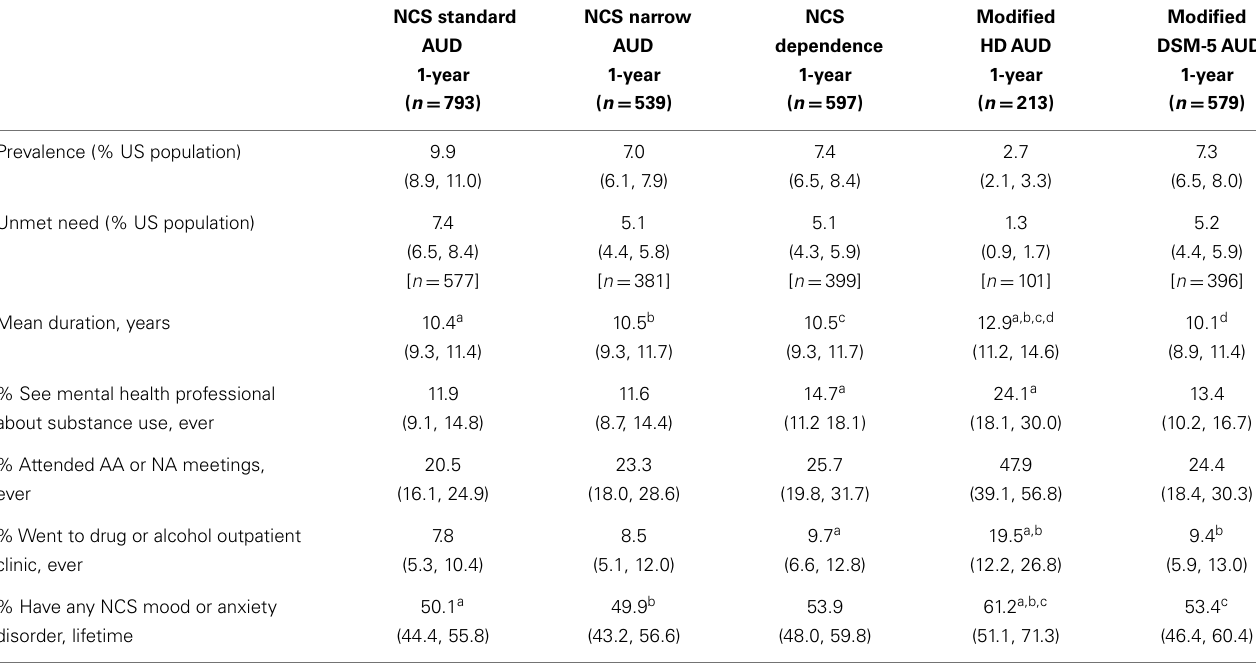
Table 1 | One-year prevalence, 1-year unmet need, and means and percentages (95% confidence intervals) of five validators of 1-year alcohol use disorder (AUD), compared for five definitions ofAUD: National Comorbidity Study (NCS) standard, NCS narrow, NCS dependence, HD, and DSM-5AUD